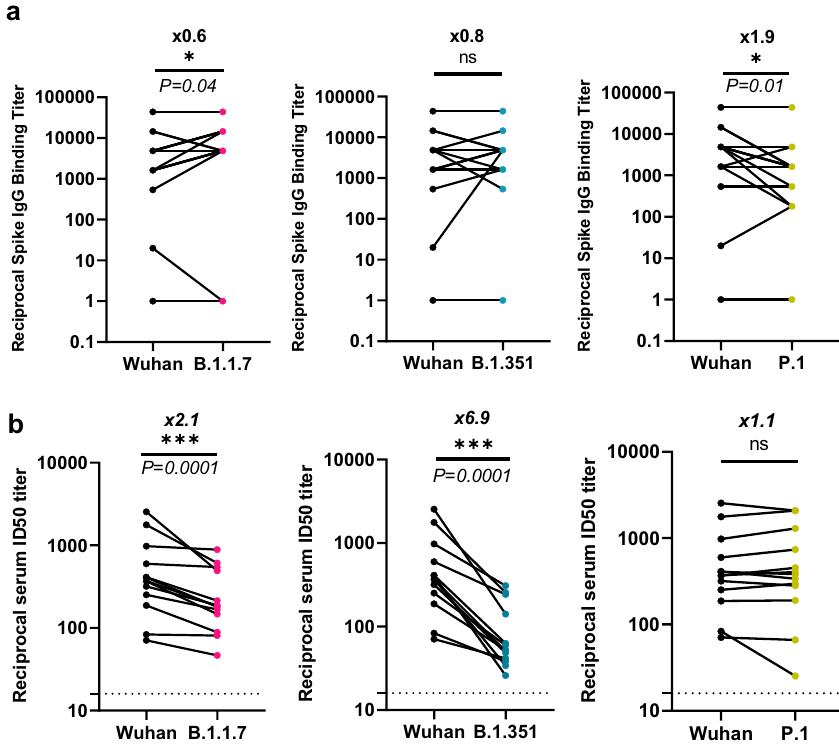
Fig. 1 Humoral antibody cross-reactivity responses against SARS-CoV-2 variants. a Sera from Phase 1 INO-4800 vaccinees were assessed by ELISA for IgG binding to Wuhan, B.1.1.7, B.1.351, and P.1 variant Spike proteins (S1 and S2). Data points indicate endpoint titers for an individual study sample (n = 4, 0.5 mg vaccine dose; n = 5, 1.0 mg; n = 11, 2.0 mg) and were calculated as the titer that exhibited an OD 3 SD above baseline. b SARS-CoV-2 pseudovirus neutralization ID50 titers for sera samples from 13 Phase 1 INO-4800 vaccinees comparing Wuhan against B.1.1.7, B.1.351, and P.1. Each data point represents the mean of technical duplicates for each individual ( n = 1, 0.5 mg vaccine dose; n = 4, 1.0 mg; n = 8, 2.0 mg). Dotted lines indicate the limit of detection of 16. ns not signi fi cant, * P < 0.05, *** P < 0.0001 (Wilcoxon signed- rank